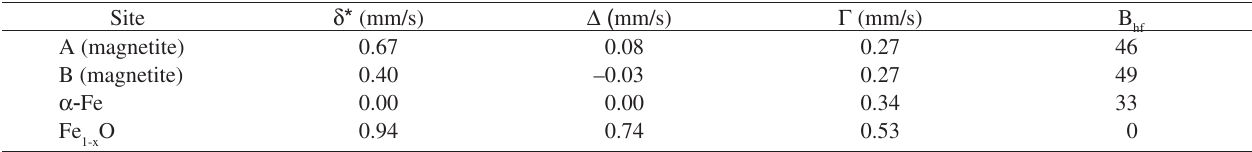
Table 1. Values used for the parameters during the experimental rolling process. Parameter Value utilized Observation Th 28 mm and 32 mm Slab thickness at the entrance of the finishing mill. ISC 12% (38 m³/h) and Relative percentage of the total water flow system; variations only in interstand cooling 1 and 2, which were equivalent, respectively to stands F1/F2 and F2/F3. Oil –30% and +30% Parameter with a variation of ± 30% of the oil flow only in stands F2, F3 and F4 in relation to the usual values utilized; in the other stands (F1, F5 and F6), the values were not modified.